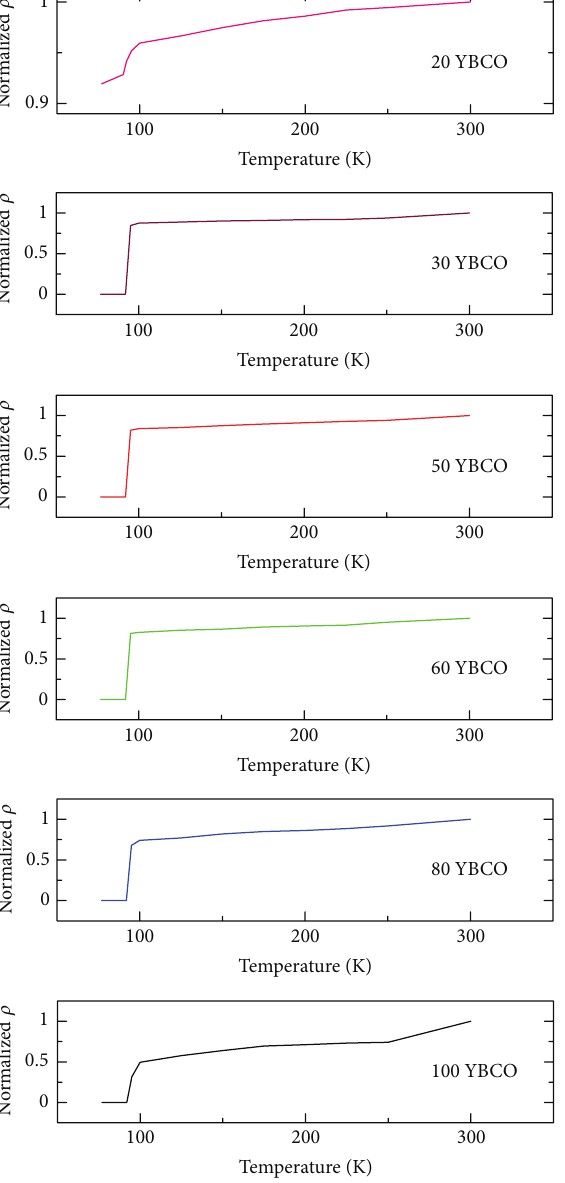
Figure 5: Temperature dependence of normalized with different volume percentages of